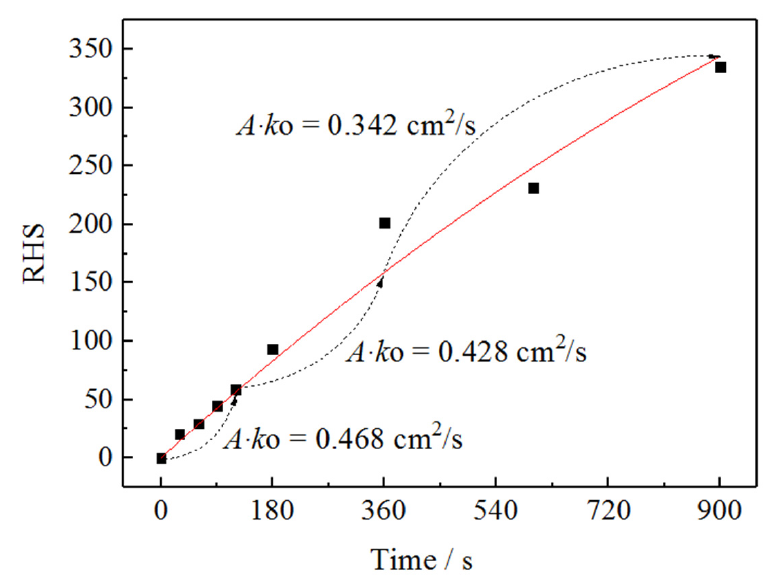
Figure 5. Relationship between RHS and time in Mori’s experiment (new model).